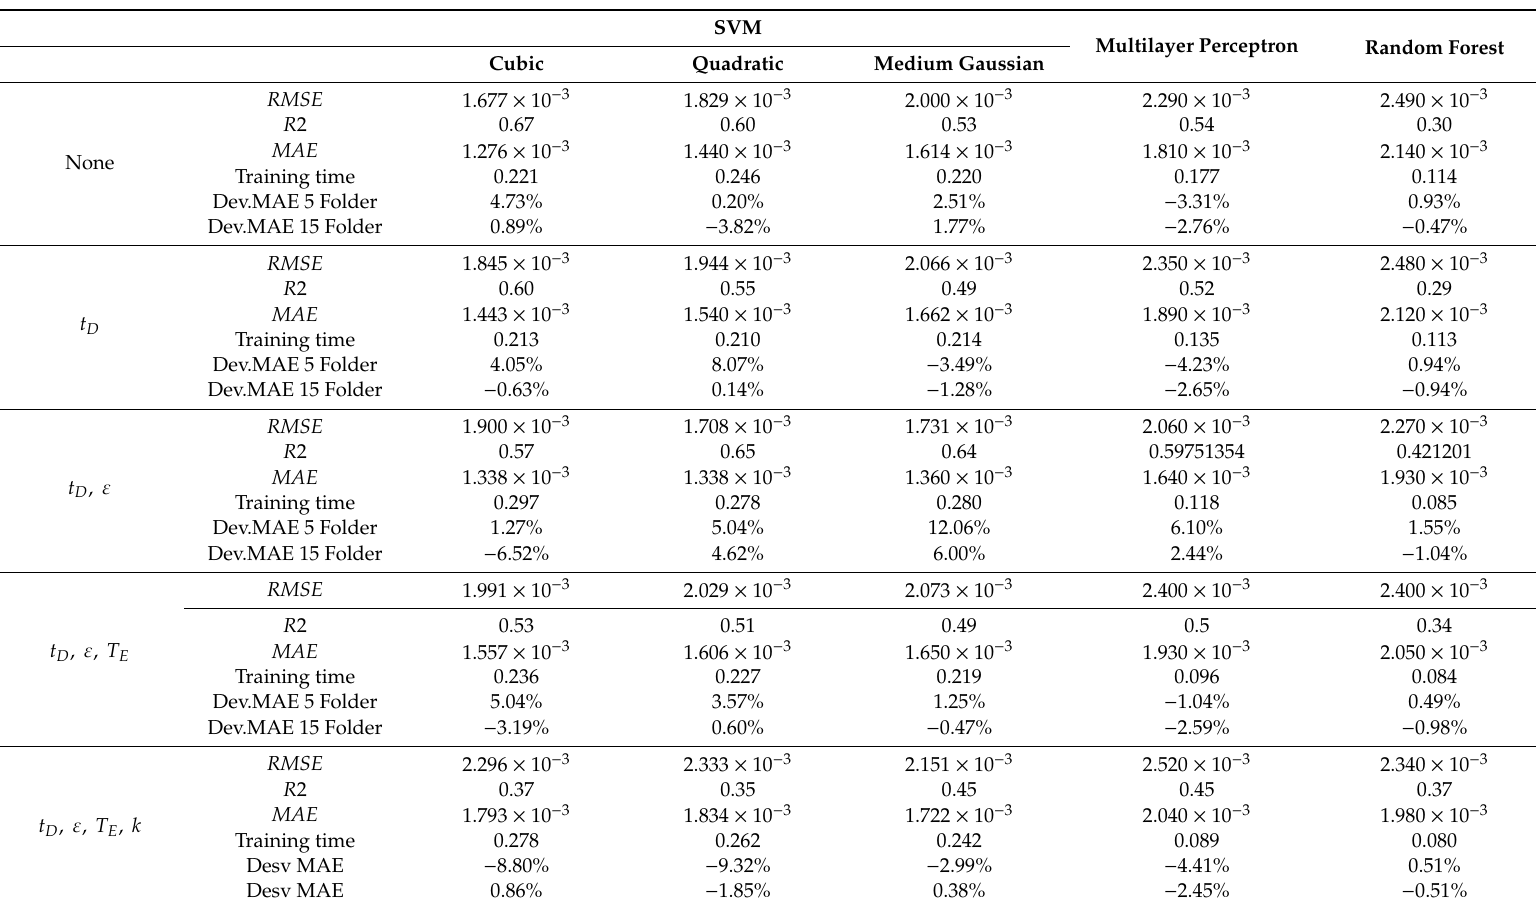
Table A6. Performance results for defect length predictor models using dataset of 500 sets of values. SVM, MLP and RF when “Contrast Rear” is not contemplated as